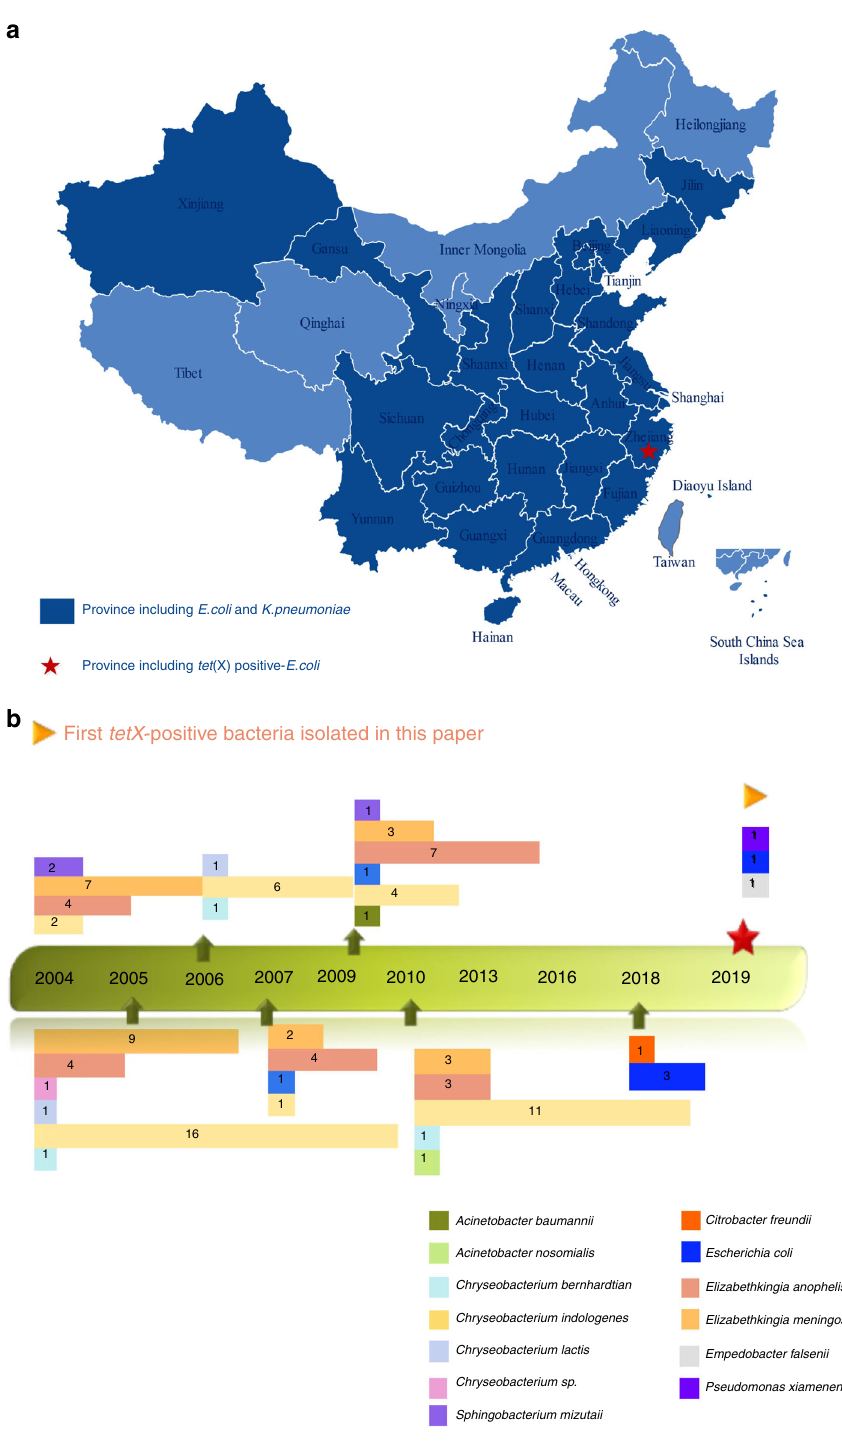
Fig. 1 Distribution of tet (X)-positive bacterial strains. a Distribution of tet (X)-positive clinical E. coli and K. pneumoniae strains in China. Dark blue background indicates provinces included in this surveillance; red star represents the province in which tet (X)-positive strains were isolated; light blue background indicates provinces in which no sample was collected. The map was created using Edraw Max v9.4. b Year of isolation of tet (X)-positive strains of speci fi c bacterial species. The number of strains isolated each year is